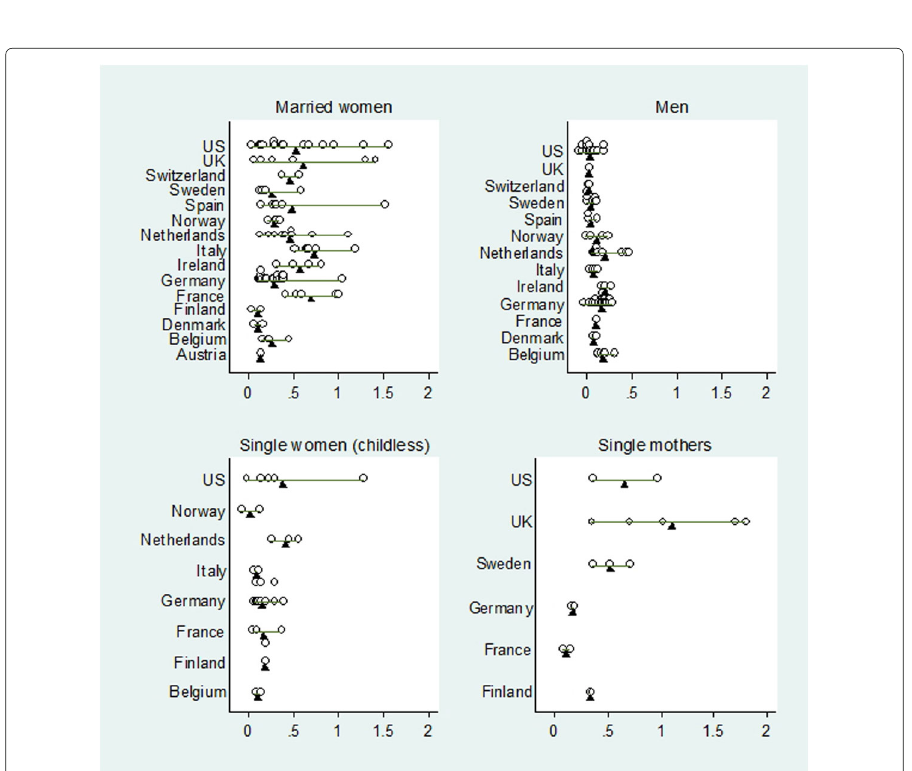
Fig. 2 Distribution of wage elasticities by demographic group and